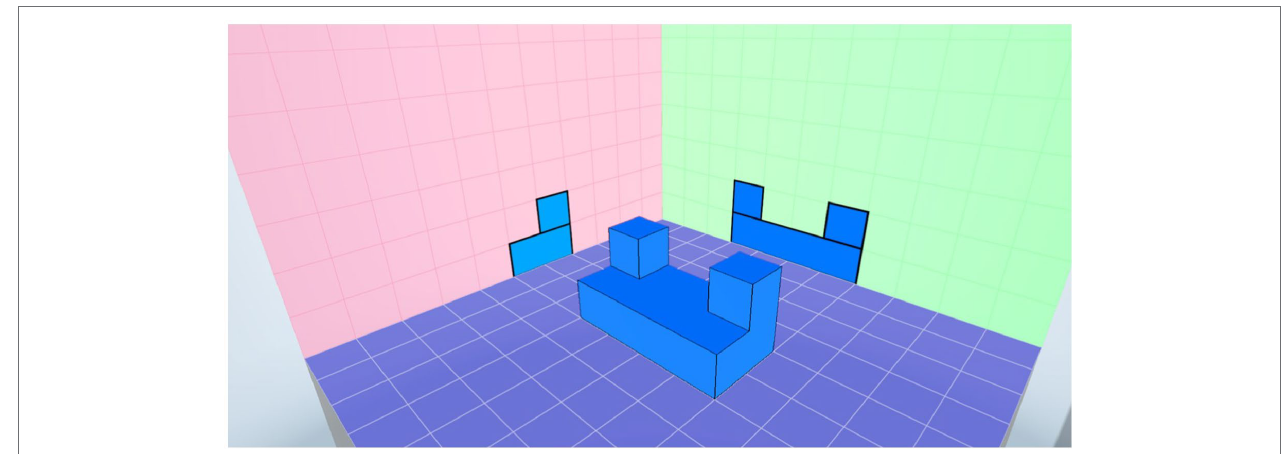
FIGURE 8 | An exemplary screenshot of completing the VR assessment.